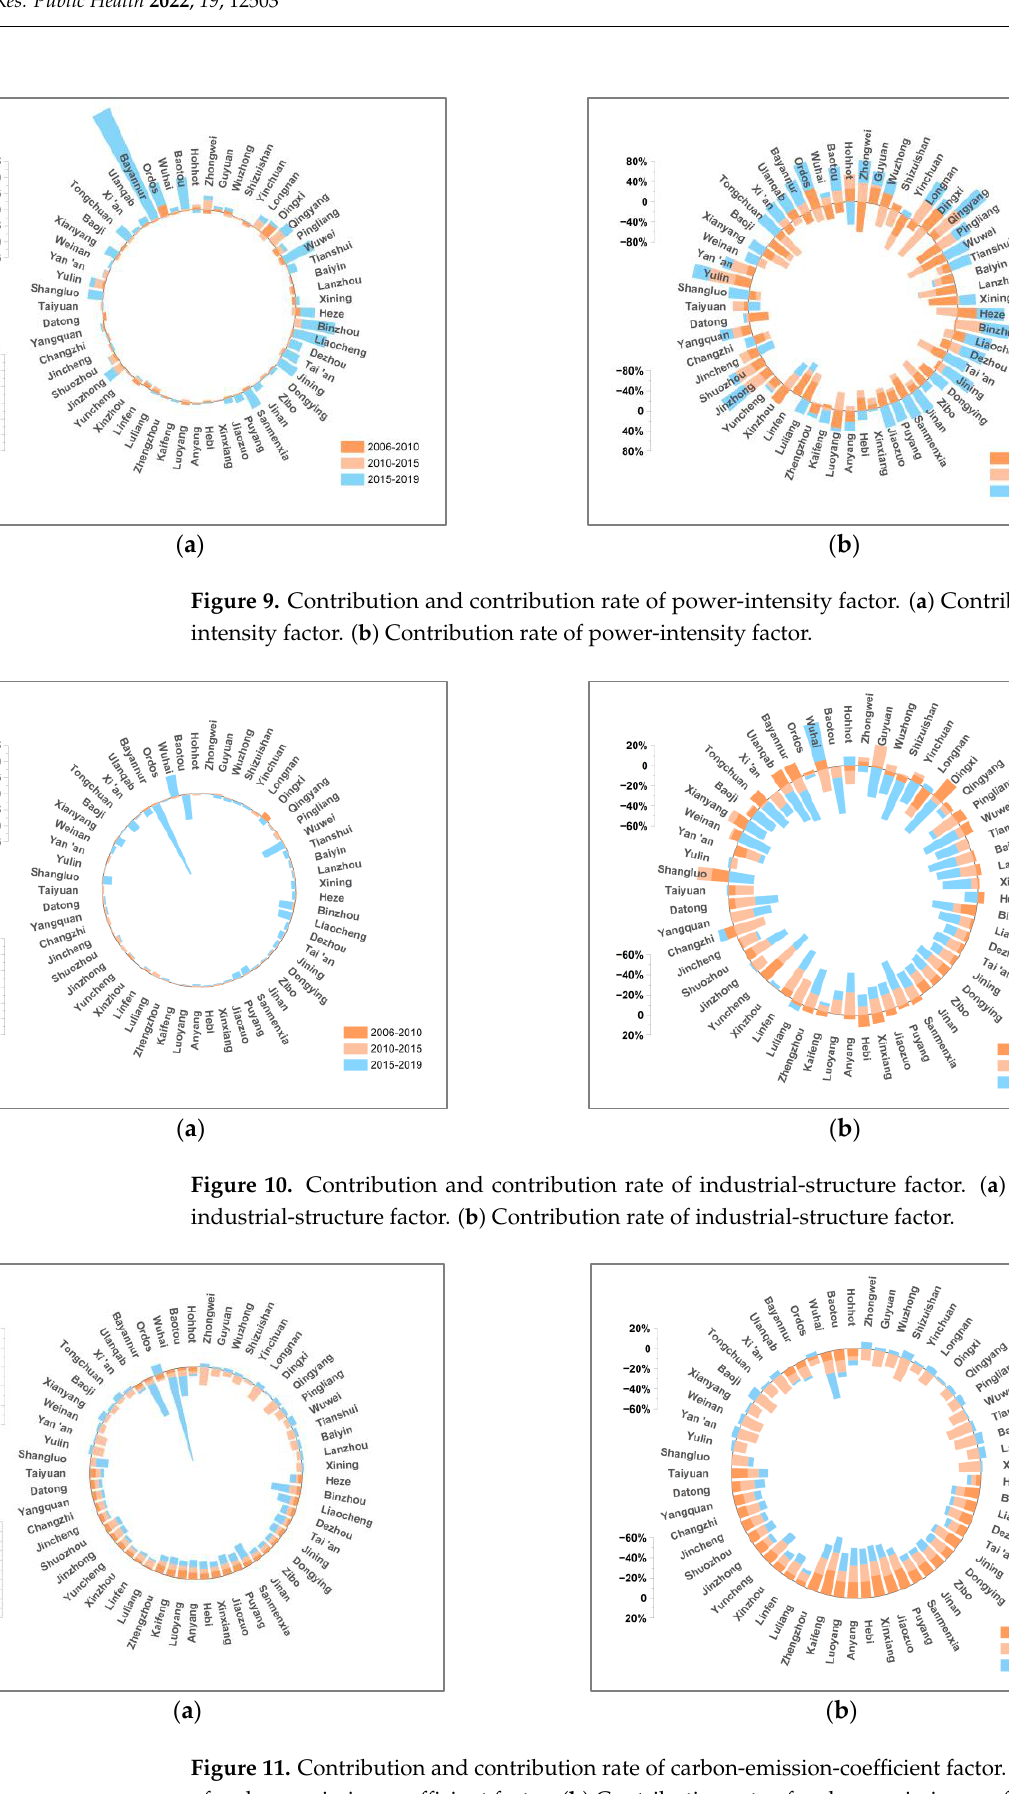
Figure 12. Contribution and contribution rate of population-scale factor. ( a ) Contribution of popu- lation-scale factor. ( b ) Contribution rate of population-scale factor.